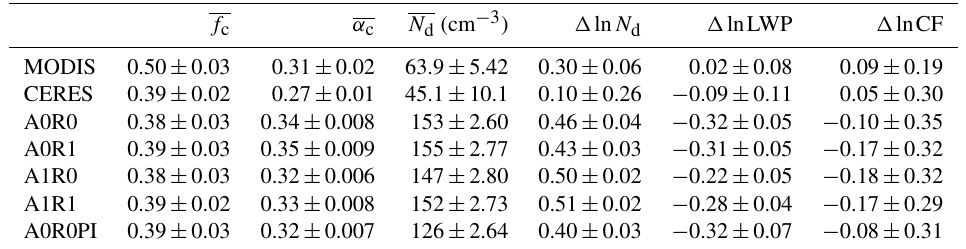
Table 7. List of quantities used to compute the aerosol indirect radiative effect averaged over the daylight period (roughly from 09:00 to 15:00LT) of the second day of each trajectory. f c α c N d (cm − 3